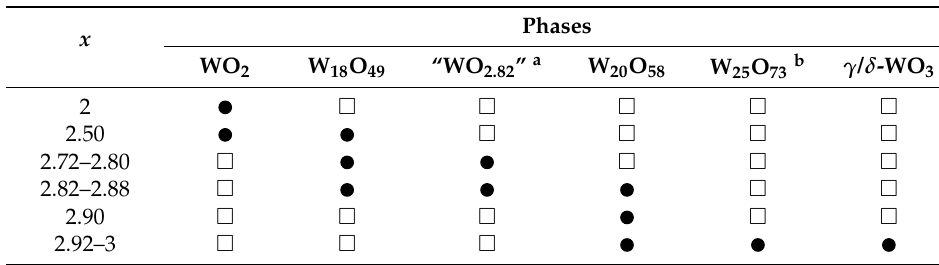
Table 2. Phases observed from PXRD in WO x samples prepared with SPS-1420 K/10 min ( ● —observed, □ —not observed) .